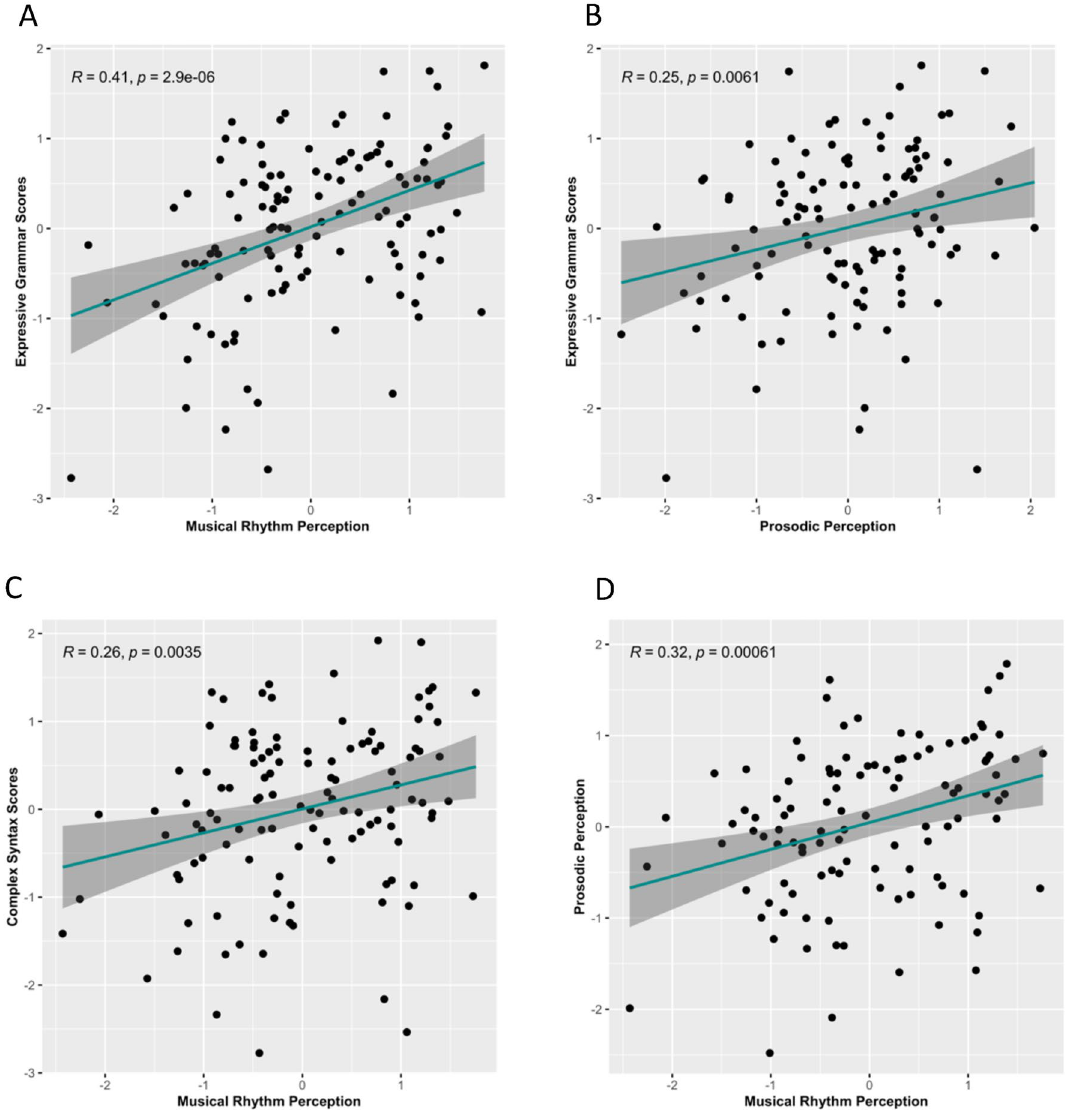
Figure 1. Scatterplots showing the correlations between variables. Scatter plots for correlations between ( A ) expressive grammar (SPELT-3) scores and musical rhythm perception ( n = 121); ( B ) expressive grammar and prosodic perception ( n = 118); ( C ) complex syntax sub-scores and musical rhythm perception ( n = 121); and ( D ) musical rhythm perception and prosody perception ( n = 109). Age is controlled for in all plots, and Pearson’s r and p values are displayed for each